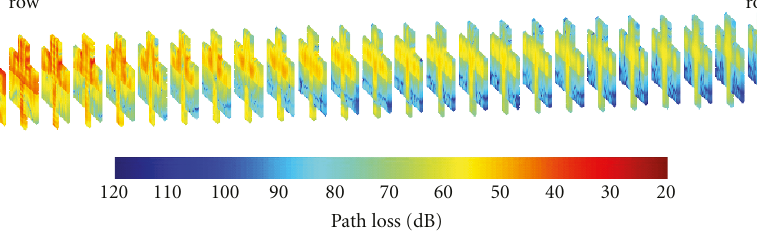
Figure 13: Example of PO results (path loss in dB) for all rows.